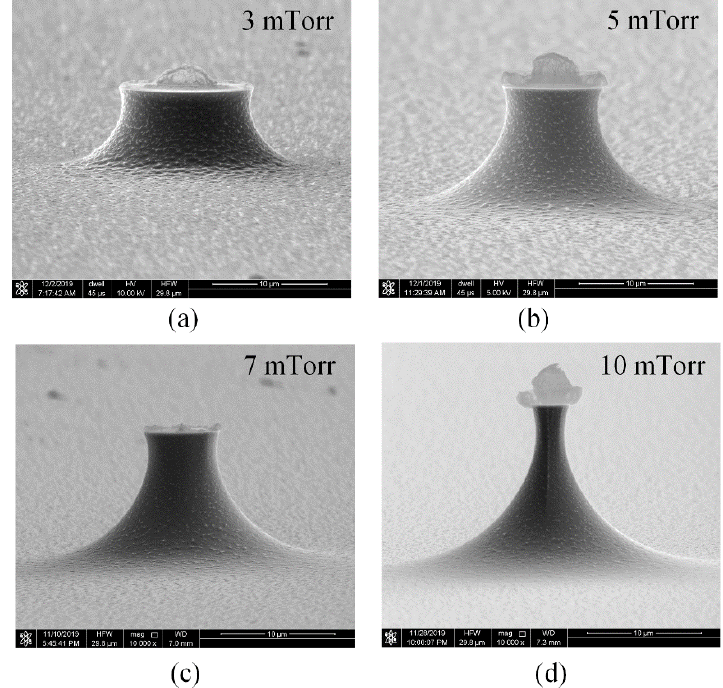
Figure 4. The tip profiles etched with circular masks under different chamber pressures with 30 sccm flow rate, 1000 W ICP power and 0 W platen power. ( a ) 3 mTorr, ( b ) 5 mTorr, ( c ) 7 mTorr, ( d ) 10 mTorr.